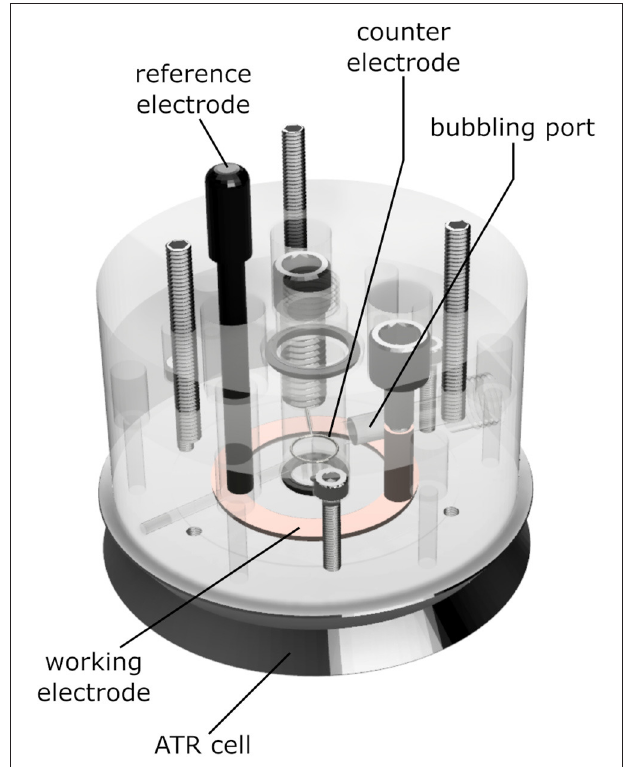
FIGURE 2 | Schematics of the ATR electrochemical cell used in the experiments. The ATR unit is a three-reflection Si crystal. The permeable gold mesh used as a working electrode contacts the copper ring highlighted in the drawing. The sample is placed on top of the mesh, over the round Si crystal at the center of the picture. An 8 kDa dialysis membrane between the sample and the electrolyte prevents sample loss and excessive swelling. The gas inlet allows saturating the electrolyte and the sample with CO gas. The body of the cell is made out of PMMA, the O-rings are butyl rubber. The materials directly contacting the sample are a Kapton TM tape insulator, gold, the Si crystal itself, and the cellulose dialysis membrane.